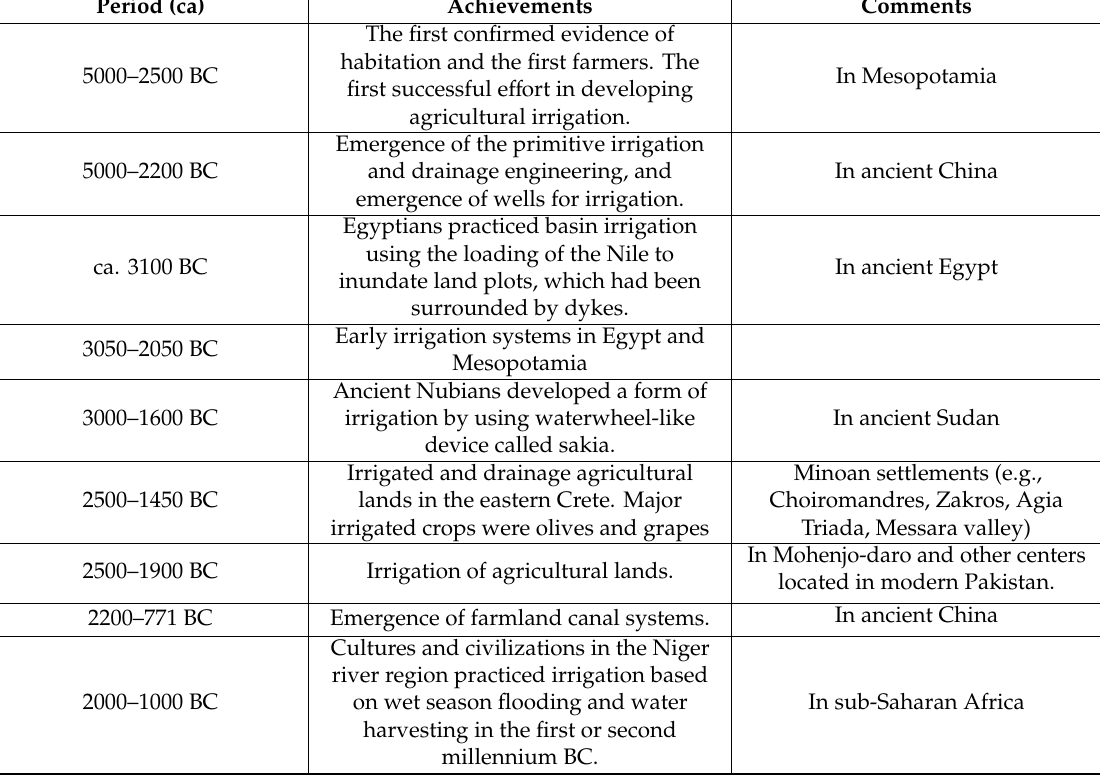
Table 3. A Brief timeline for historical development of agricultural